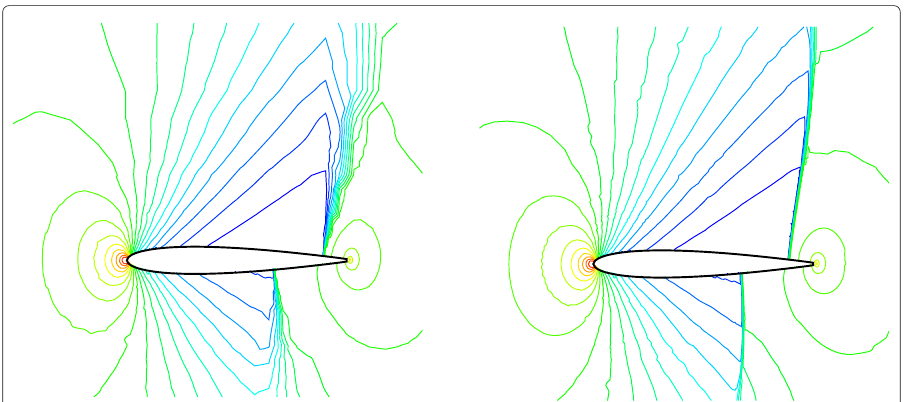
Fig. 13 Pressure contours for the problem of inviscid flow over a single NACA0012 airfoil. Left: without solution-based refinement. Right: with solution-based